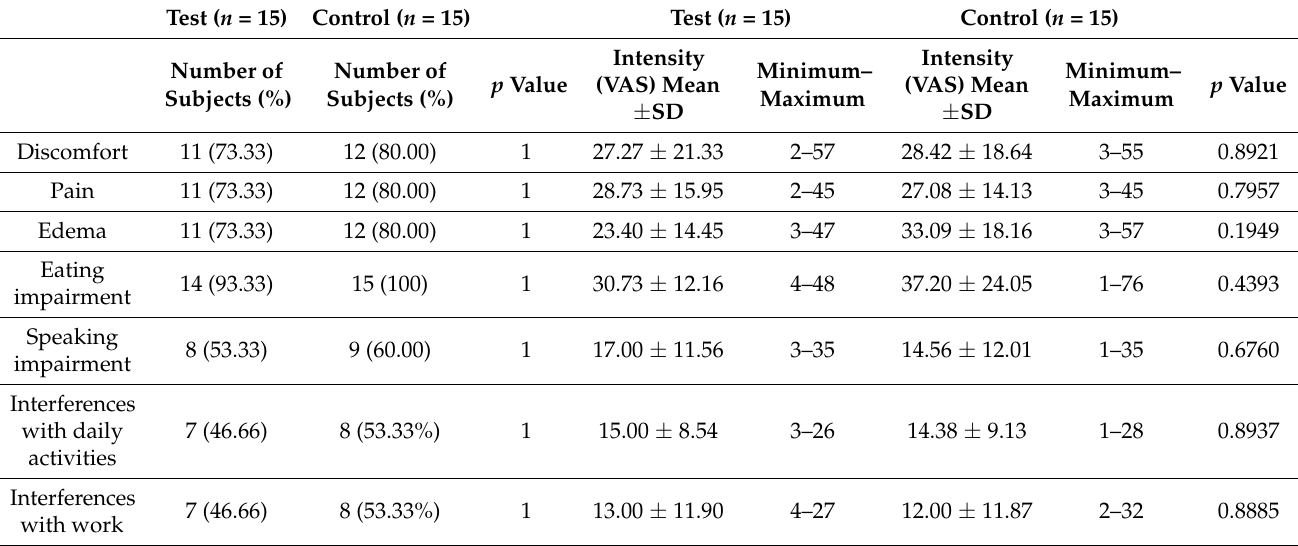
Table 4. Subject experience in terms of post-operative morbidity ( N =